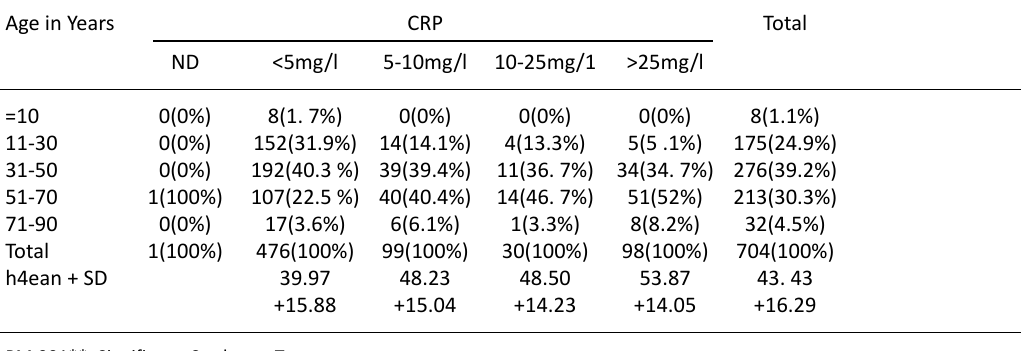
Table 4. Correlation of Age distribution with C reactive protein in patients of COVID Age in